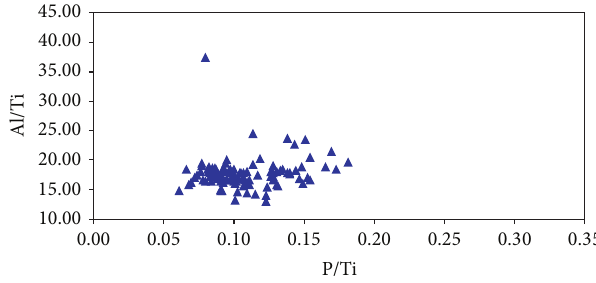
Figure 5: The cross plot showing the relationship between P/Ti ratios and Al/Ti ratios of Miocene source rocks in the Qiongdong- nan Basin. Note: the samples in the chart are from the whole region of the basin. The information of the samples mainly represents the shallowwaterareabecausemostofthewellsdistributeintheshallow water area (mainly in delta or coastal area).